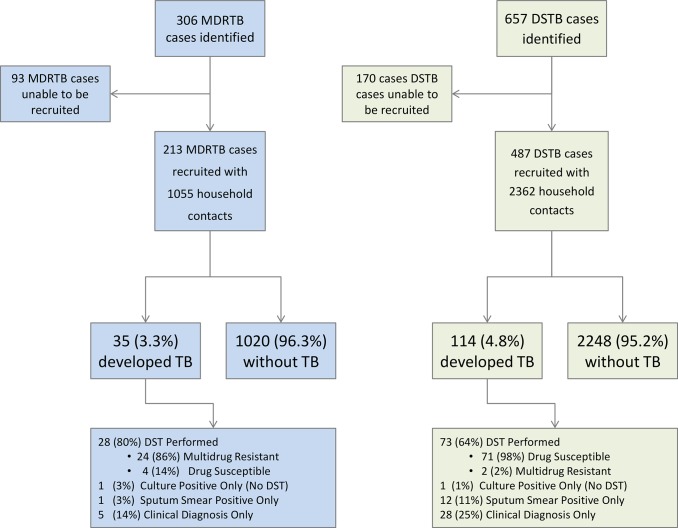
Flow diagram of recruitment to the study and study outcomes.DST, drug susceptibility testing; DSTB, drug-susceptible tuberculosis; TB, tuberculosis.